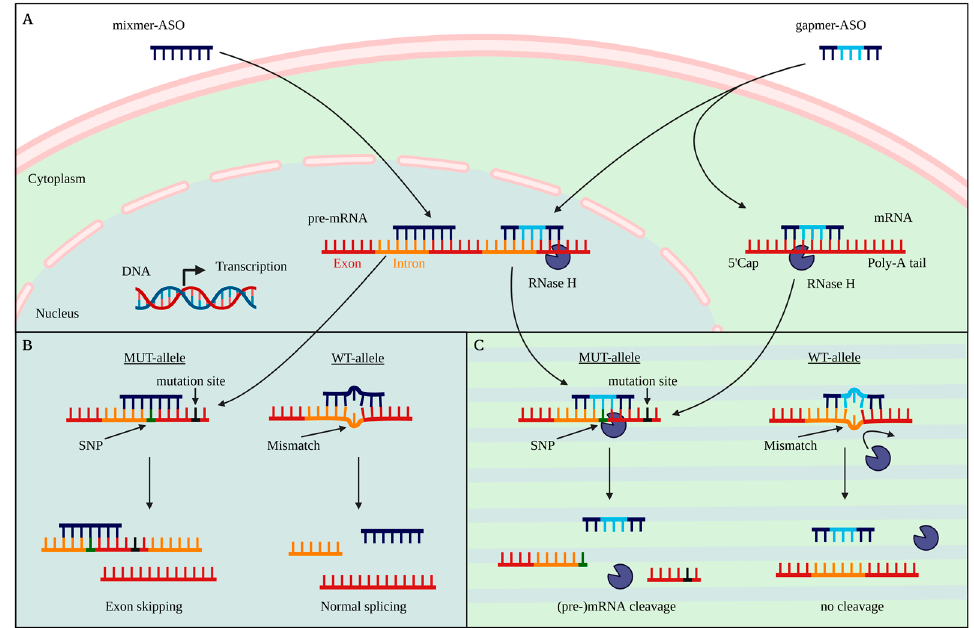
Figure 1. Mode of action of allele-specific antisense oligonucleotide strategies. ( A ) Mixmer ASOs and gapmer ASOs can be transported through cell membranes and nuclear pores to target (pre-)mRNA. ( B ) Mixmers act as a steric block that binds to the target pre-mRNA and can modulate the splicing process. Steric block ASOs can be used to selectively target the SNP region and therefore, modulate splicing. Binding to the WT allele has a lower affinity compared to the MUT allele, due to a mismatch. This results in a less effective splicing modulation. ( C ) Gapmer ASOs can either bind intronic regions or exonic regions of (pre)-mRNA in the nucleus or cytoplasm. Binding of gapmers with their target (pre-)mRNA recruits RNase H. The DNA:RNA binding leads to a degradation of the (pre-)mRNA. SNPs that appear on the same allele as the disease-causing mutation, such as a CAG repeat expansion, can be directly targeted with an ASO, potentially leading to a mutant-specific degradation. The mismatch on the WT allele results in a conformational change that leads to a reduced cleavage capacity.